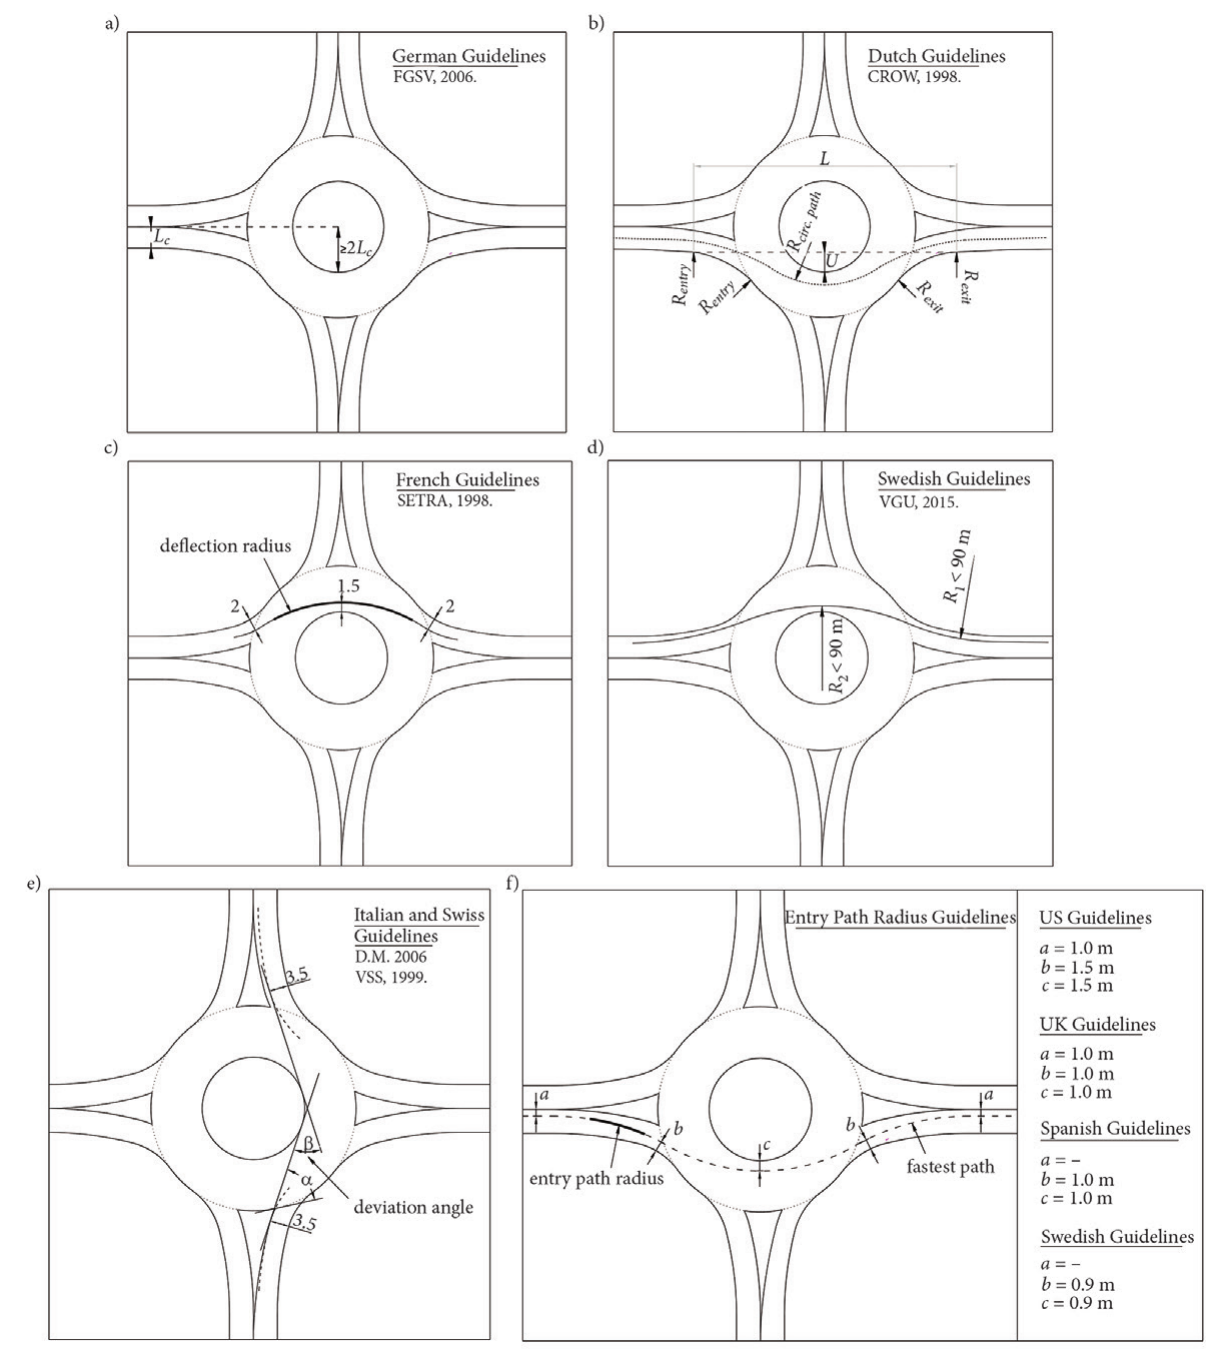
Figure 1. Summary of the main parameters used for controlling deflection at